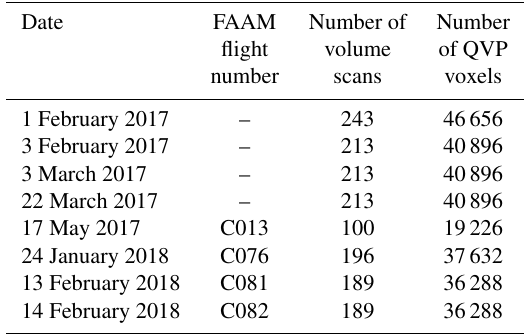
Table 1. In situ data collection